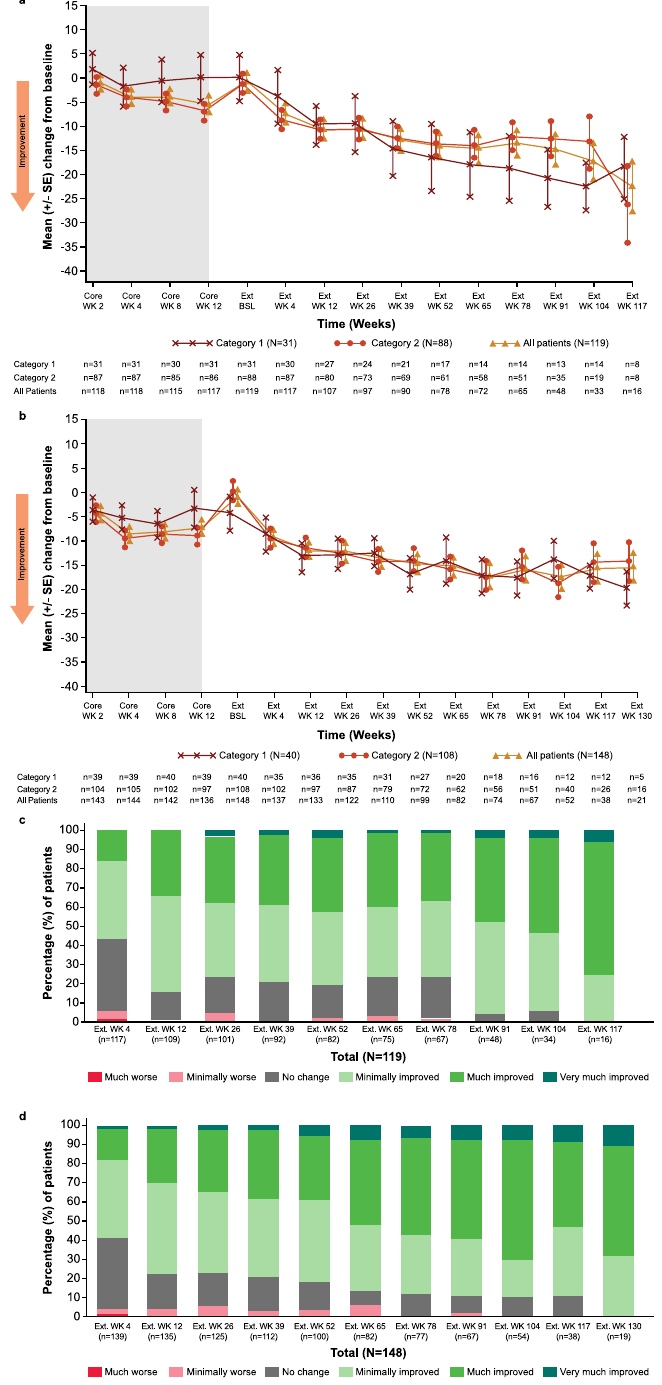
Figure 2. ABC-C FX LS Mean Change from core study baseline in ( a ) adolescents and ( b ) adults and distribution of CGI-I ratings from extension study baseline in ( c ) adolescents and ( d ) adults * . Category 1: treated with mavoglurant in core study and entered the open-label extension study within 1 week of core study completion. Category 2: treated with placebo in core study or entered the open-label extension study more than 1 week after core study completion. Ext, extension; SE, standard error; WK, Week. * All patients regardless of methylation